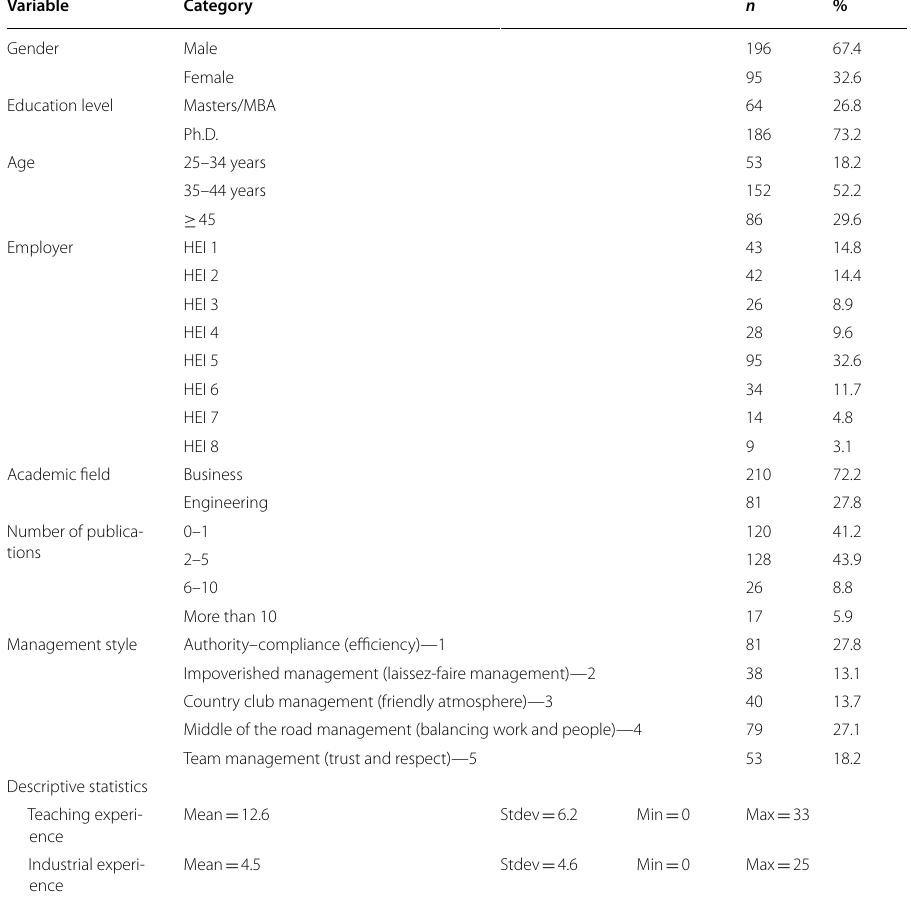
Table 1 Distribution of the sample